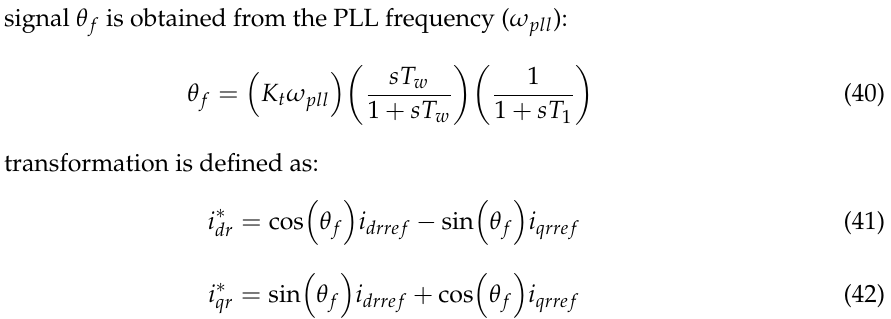
Figure 9. Block diagram for PSS with transformation technique.